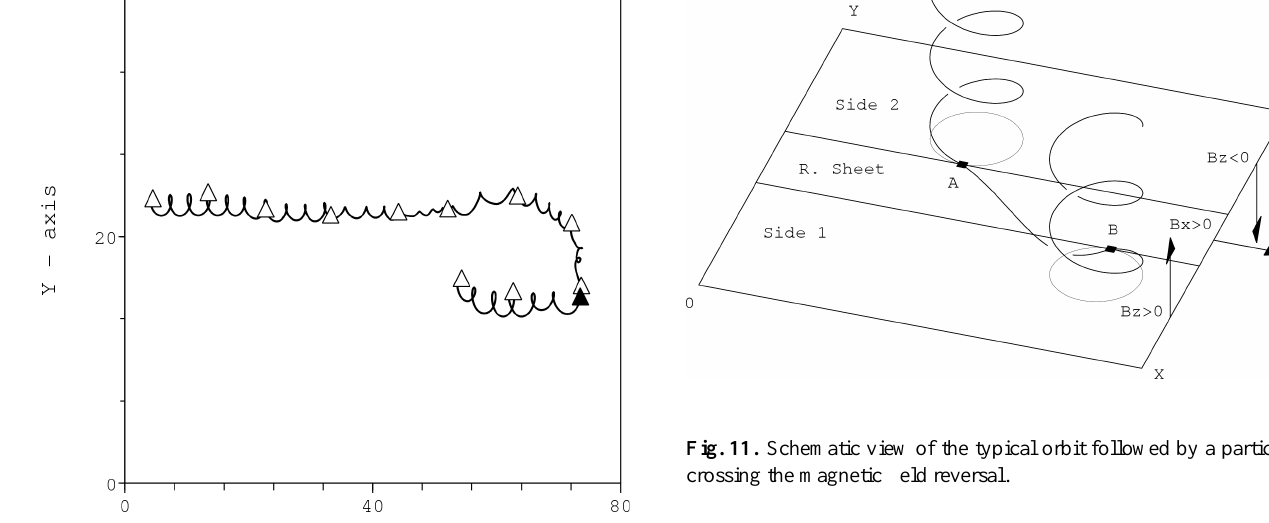
Such behaviors were already reported in Smets (2000).